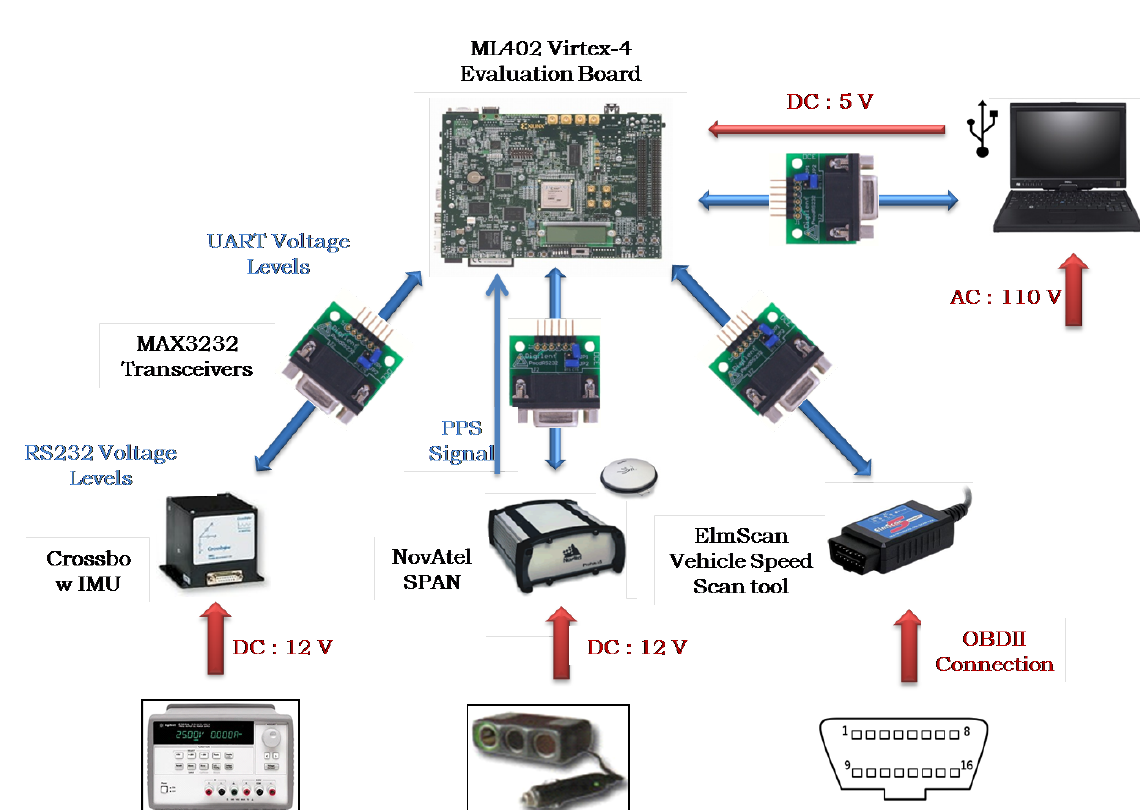
Figure 21. Land Vehicle Equipment Wiring